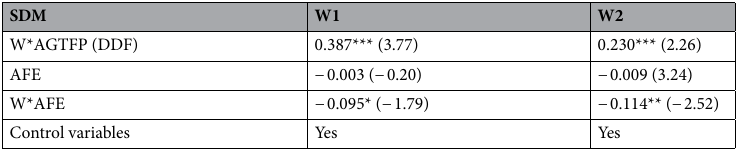
Table 8. Robustness test. *, **, *** indicate significance at the 10%, 5% and 1% level. For the estimated coefficients, the standard errors are in parentheses.